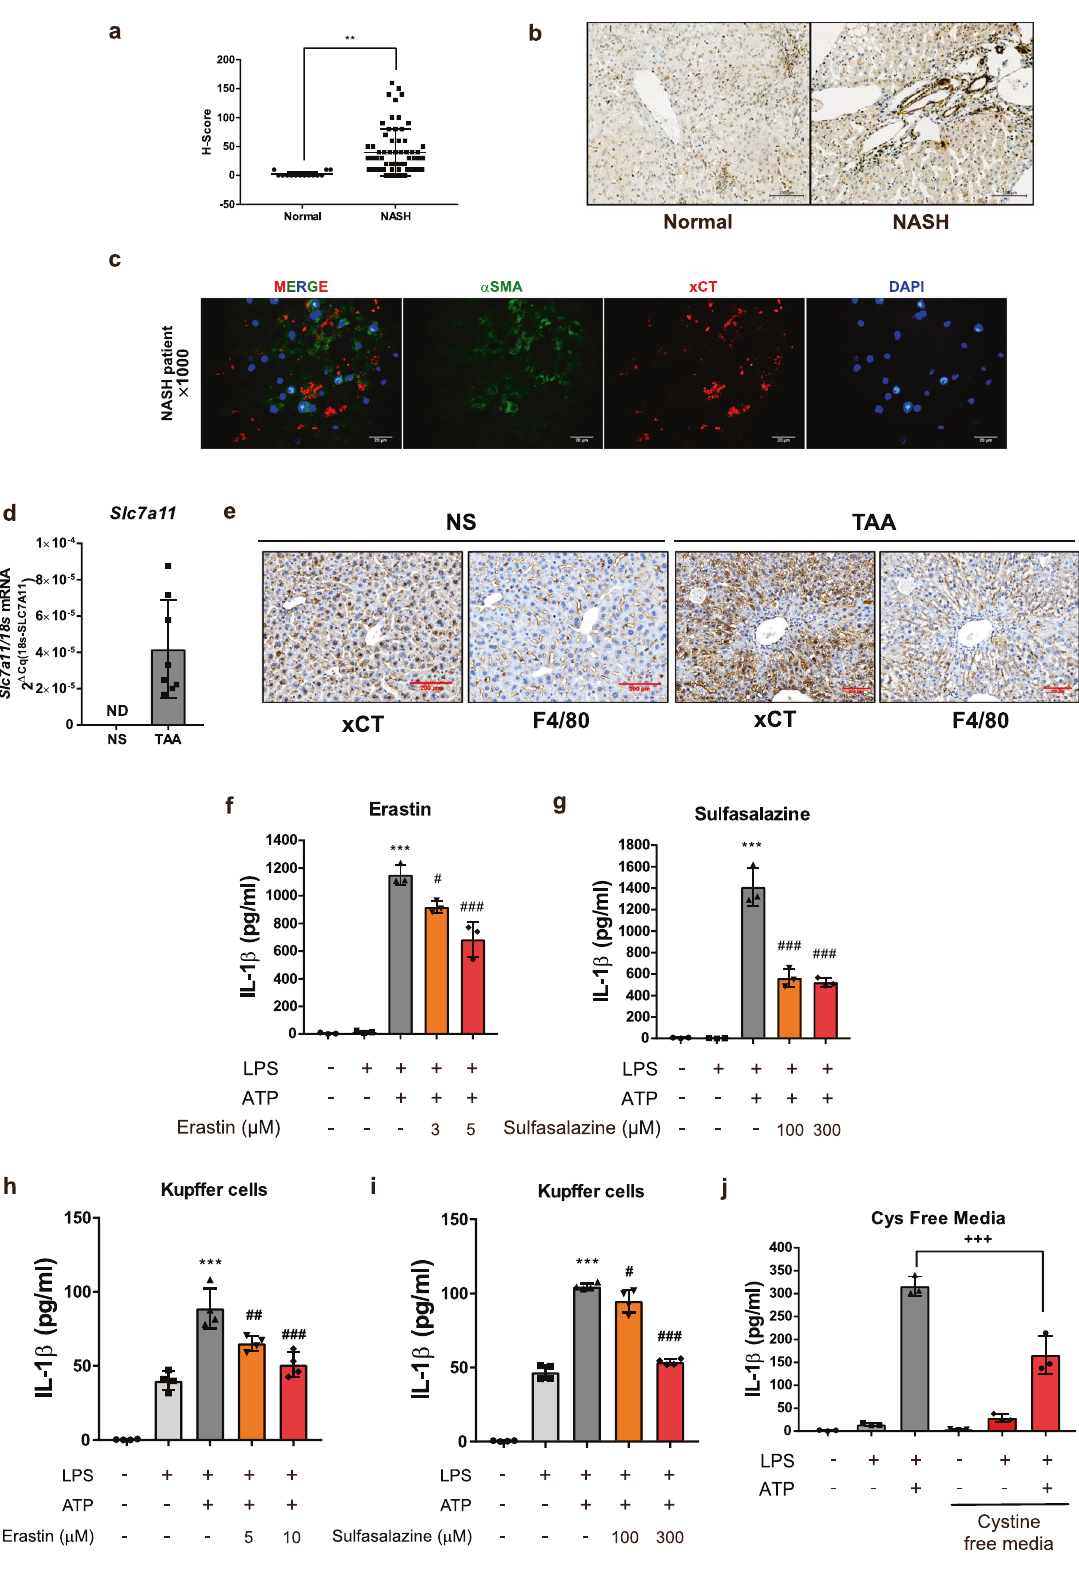
the protein level of pro-IL-1 β in BMDMs, LPS-inducible pro-IL- 1 β expression was not altered by 1 h incubation with NAC or xCT inhibitors (Supplementary Fig. 4), which implies that xCT- mediated redox change is not related to LPS priming signal. Based on the novel mechanism of action of aurano fi n, our fi ndings further indicate that inhibition of system Xc